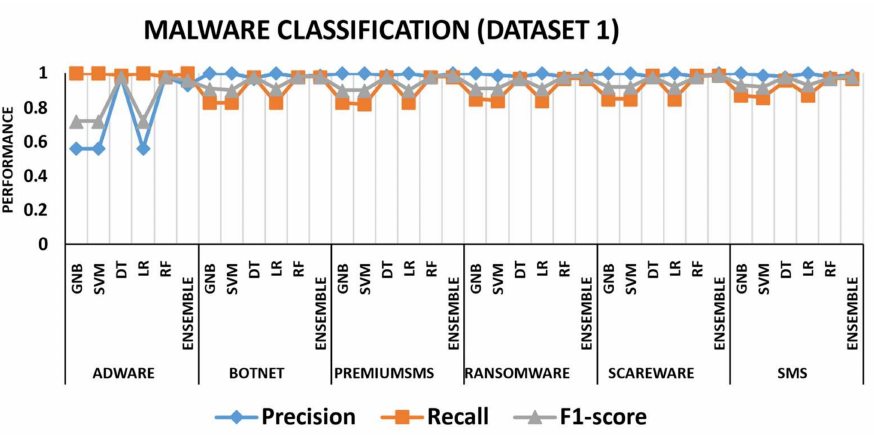
Figure 9. Performance measure (precision, recall, f1-score) comparisons for malware detection dataset 1.